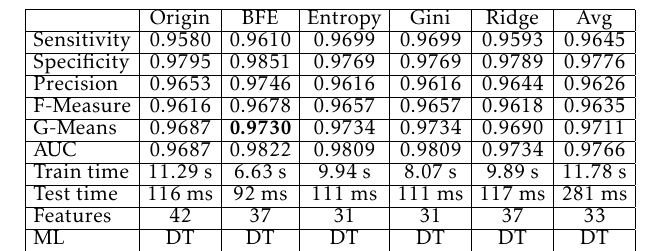
Table 39. The effect of feature reducing with attacks using BFE.